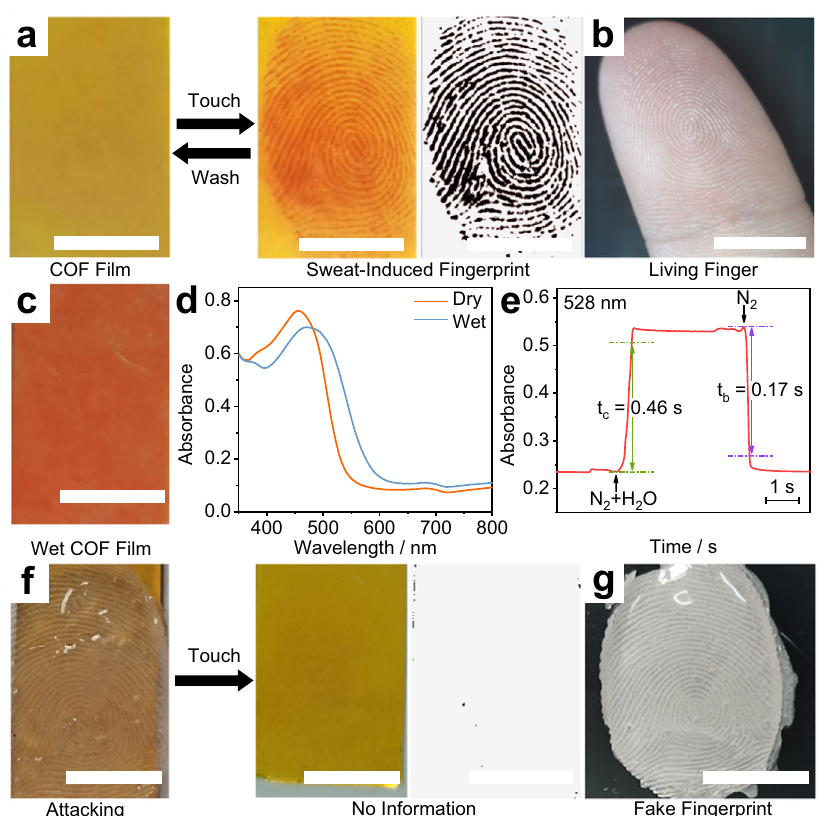
Fig. 3 | Sweat-induced fi ngerprint collected by COF TPDA-TFPy fi lm. a Photograph of COF TPDA-TFPy fi lmbeforeand afterthe touchof human fi ngersfor 10stakenbya smartphone. The image with grey background is the sweat-induced fi ngerprint extractedusingPhotoshop.Theblackcoloredimagesareaddedpseudocolorsbya Photoshop program for clear display. b Photographs of a living fi nger.